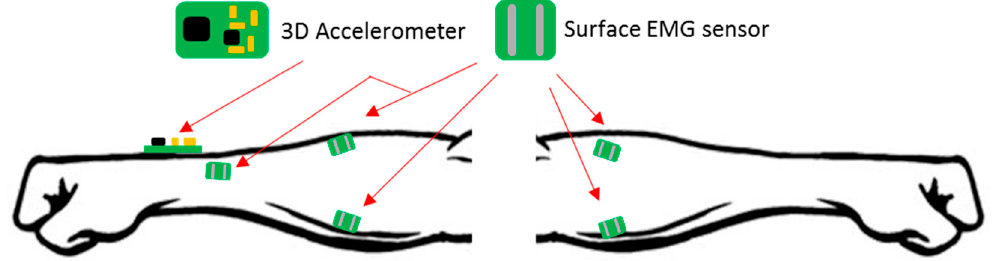
Figure 14. Sensor Fusion proposed using accelerometers and EMG electrodes.